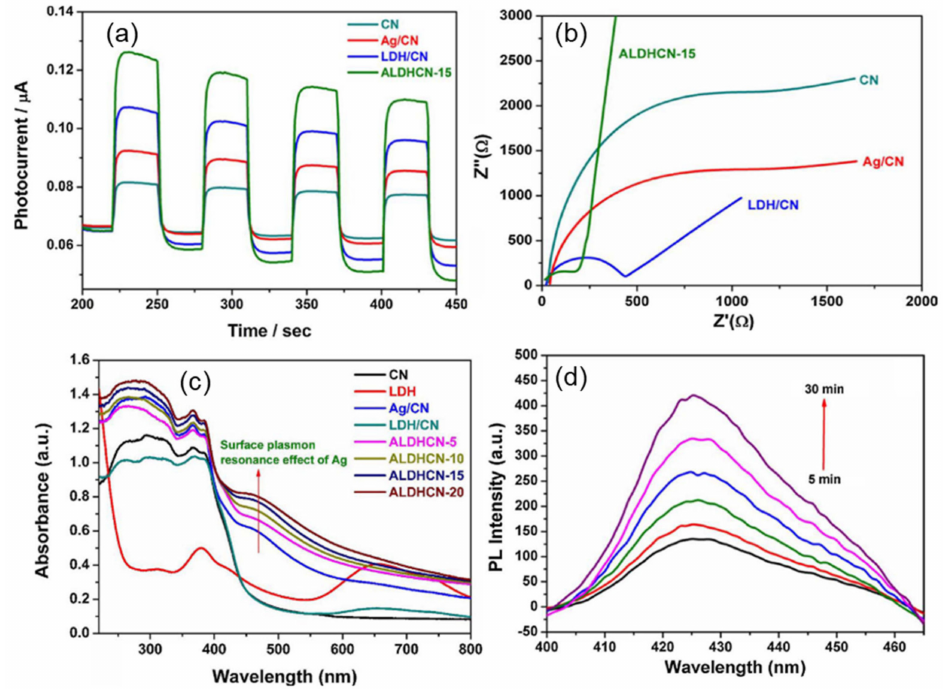
Figure 8. ( a ) Plots of photocurrent responses, ( b ) EIS curves of CN, Ag/CN, LDH/CN, and ALDHCN- 15 photocatalysts, ( c ) UV–vis-DR profiles of CN, LDH, Ag/CN, LDH/CN, and Ag/LDH/CN catalysts and ( d ) . OH capturing PL profiles of ALDHCN-15 in TA solution under visible-light illumination (Reprinted from [110] with permission of Elsevier, 2018).